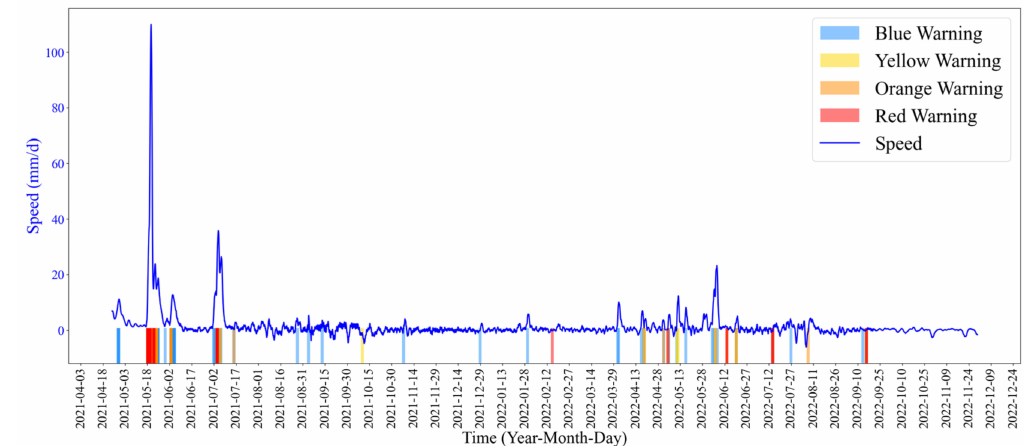
Figure 19. Threshold warning results of the Shangmao